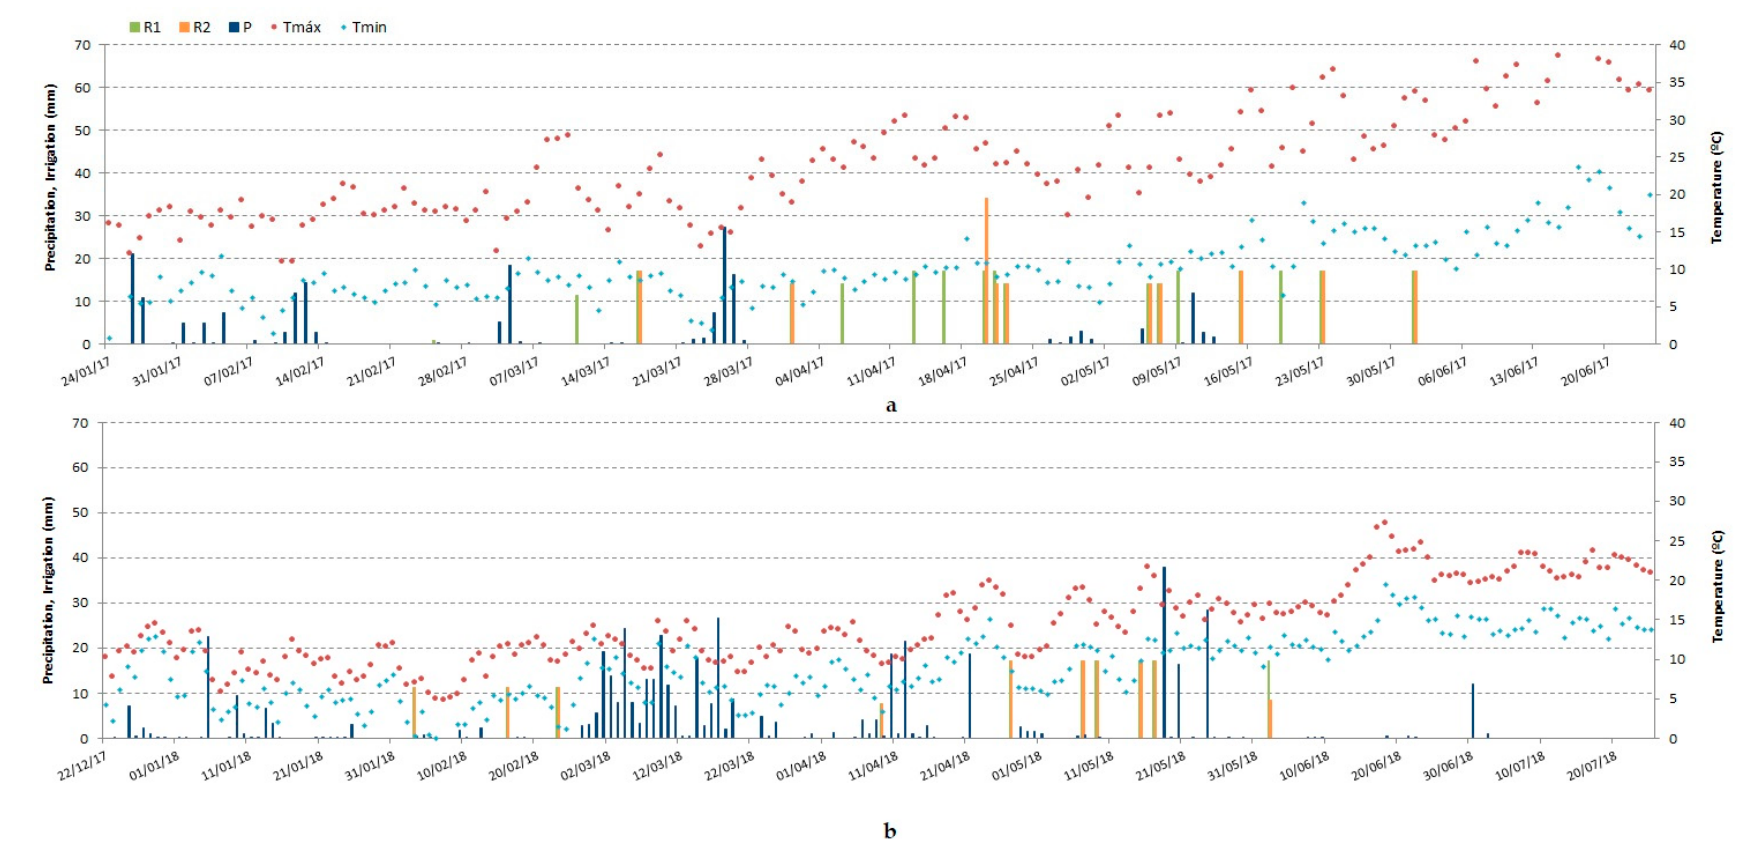
Figure 1. Irrigation depths (R1 and R2), precipitation (P), maximum daily temperature (Tmax), and minimum daily temperature (Tmin) in Beja. a -2016/2017 crop cycle; b -2017/2018 crop cycle. R1, 100% of crop evapotranspiration (ETc); R2, 100% of ETc at the critical stages of beginning of stem extension, booting, heading, and grain filling.